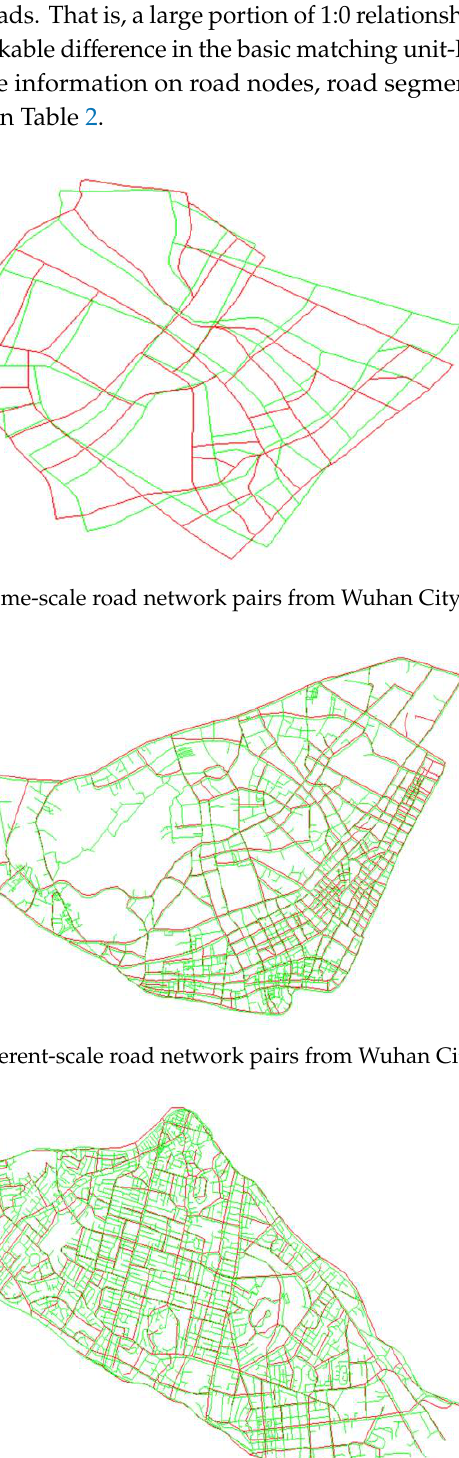
Figure 15. Different-scale road network pairs from Auckland City (Area 3). Figure 15. Di ff erent-scale road network pairs from Auckland City (Area Table 2. Three pairs of road networks used for experiments.